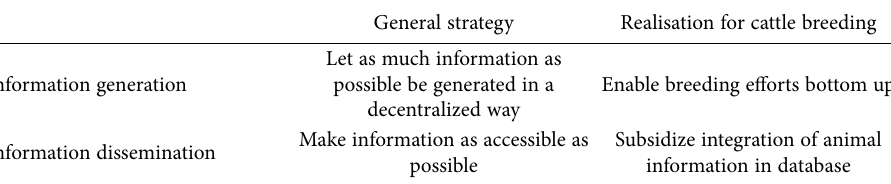
Table 1. A framework for strengthening competitiveness in information-intensive